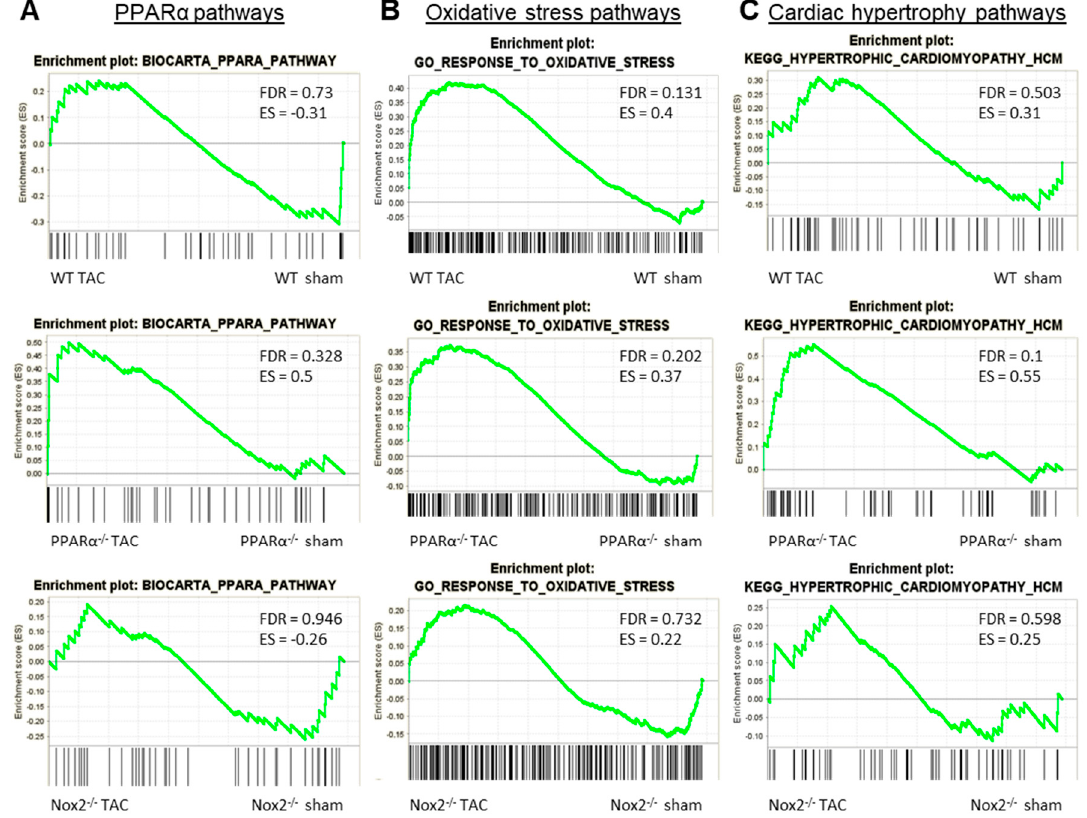
Figure 6. GSEA comparison of alterations in key pathways in WT, PPAR α − / − and Nox2 − / − mice subjected to pressure overload . Plots depicting expression of cardiac transcripts in sham vs. TAC mice across different genotypes: ( A ) Biocarta PPAR α pathway, ( B ) GO response to oxidative stress, and ( C ) KEGG hypertrophic cardiomyopathy pathway. N = 3 − 4.